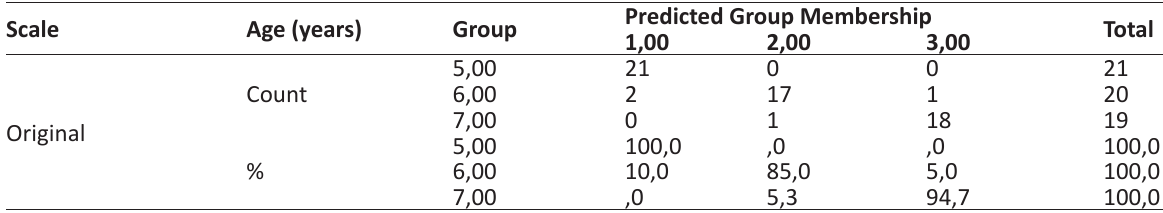
Six standing accuracy ball handlings to a partner from a 7 m distance using one of the techniques learned Evaluation of the ability to differentiate movement speed (reproduction accuracy of running speed at 80% intensity of maximum) Evaluation of the sense of movement speed in sprinting 11 Evaluation of the ability for vestibular (statokinetic) stability. Running with turns ,055 Table 5. Classification Results a . Boys aged 11-13 years old Scale